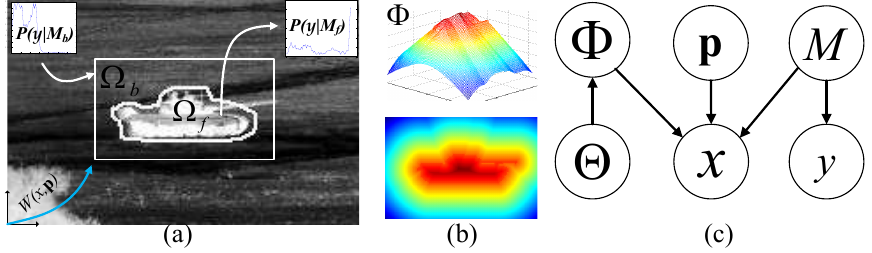
Figure 4. Shape-aware level set model for implicit shape matching. ( a ) Illustration of a target in an infrared image: foreground Ω and background Ω , foreground/background intensity f b models M , and the 3D-2D camera projection W(x, p ) . ( b ) The shape embedding function Φ . ( c ) The graphical model for shape-aware level set, where p is the target 3D location of a ground-vehicle, and Θ is the shape parameter in